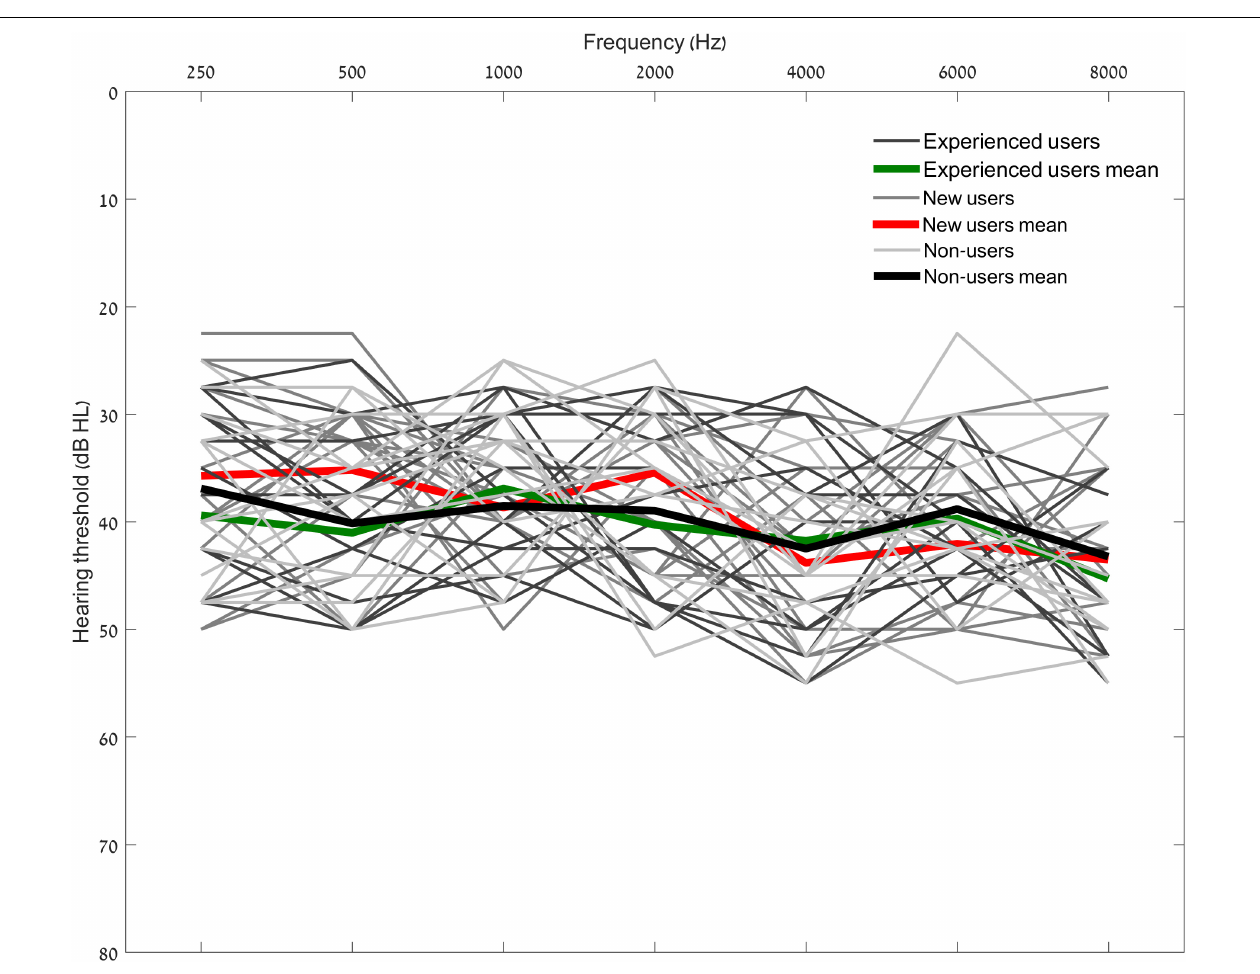
FIGURE 1 | Audiograms. Individual and Mean unaided hearing thresholds (dB HL) (average of both ears) are plotted for the experienced users (green), new users (red), and non-users (black). No significant differences were observed in any of the tested frequency ( p > 0.07) or the pure tone average (PTA) (Experienced users PTA = 40 dB HL, SD = 5.5; New users PTA = 38 dB HL, SD = 3; Non-users PTA = 39.93 dB HL, SD = 4.6; p = 0.31) of each